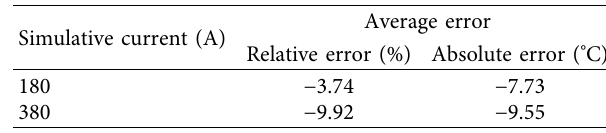
Table 3: Calculation error of trisection transient thermal circuit model under various load